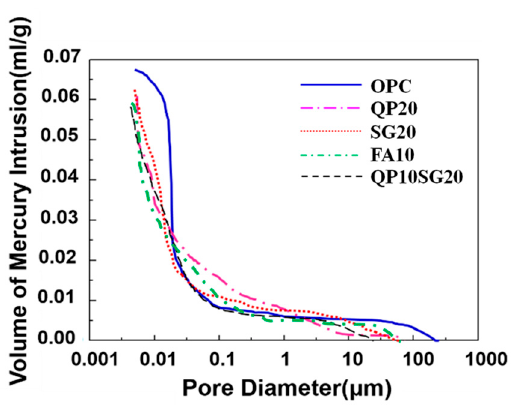
Figure 6. The relationship of volume of mercury intrusion and pore diameter.